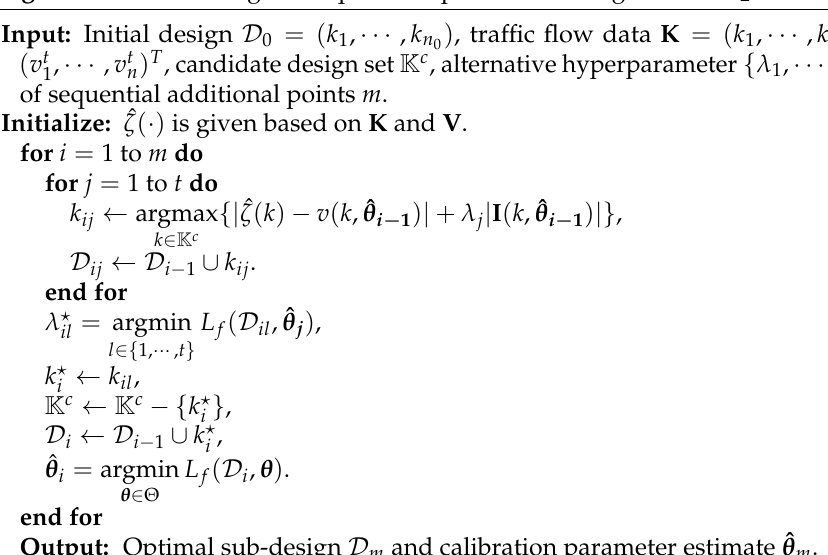
Algorithm 1 Generating the sequential optimal sub-design for the L 2